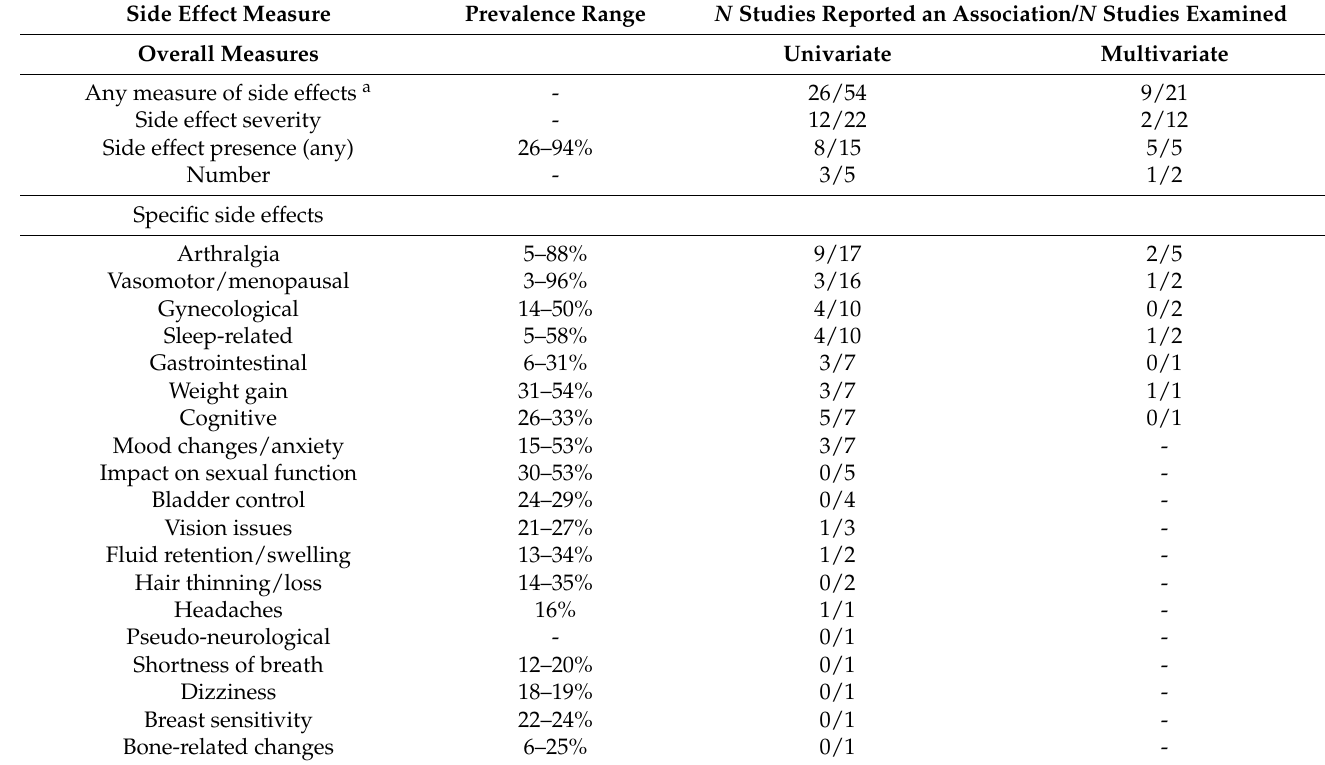
Table 3. Characteristics of studies that measured side effects ( N =